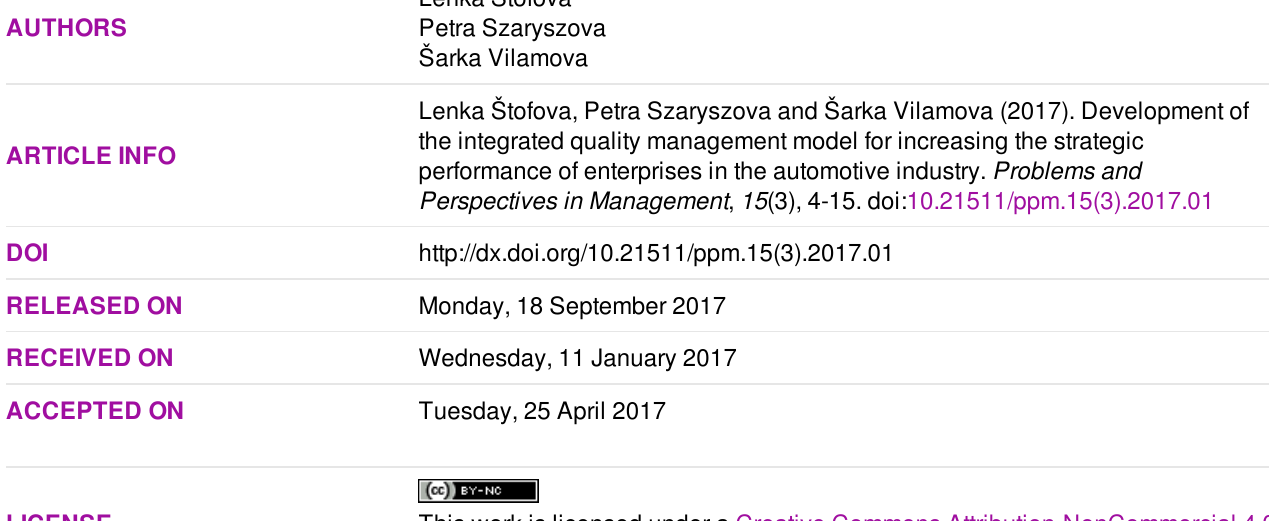
the integrated quality management model for increasing the strategic performance of enterprises in the automotive industry. Problems